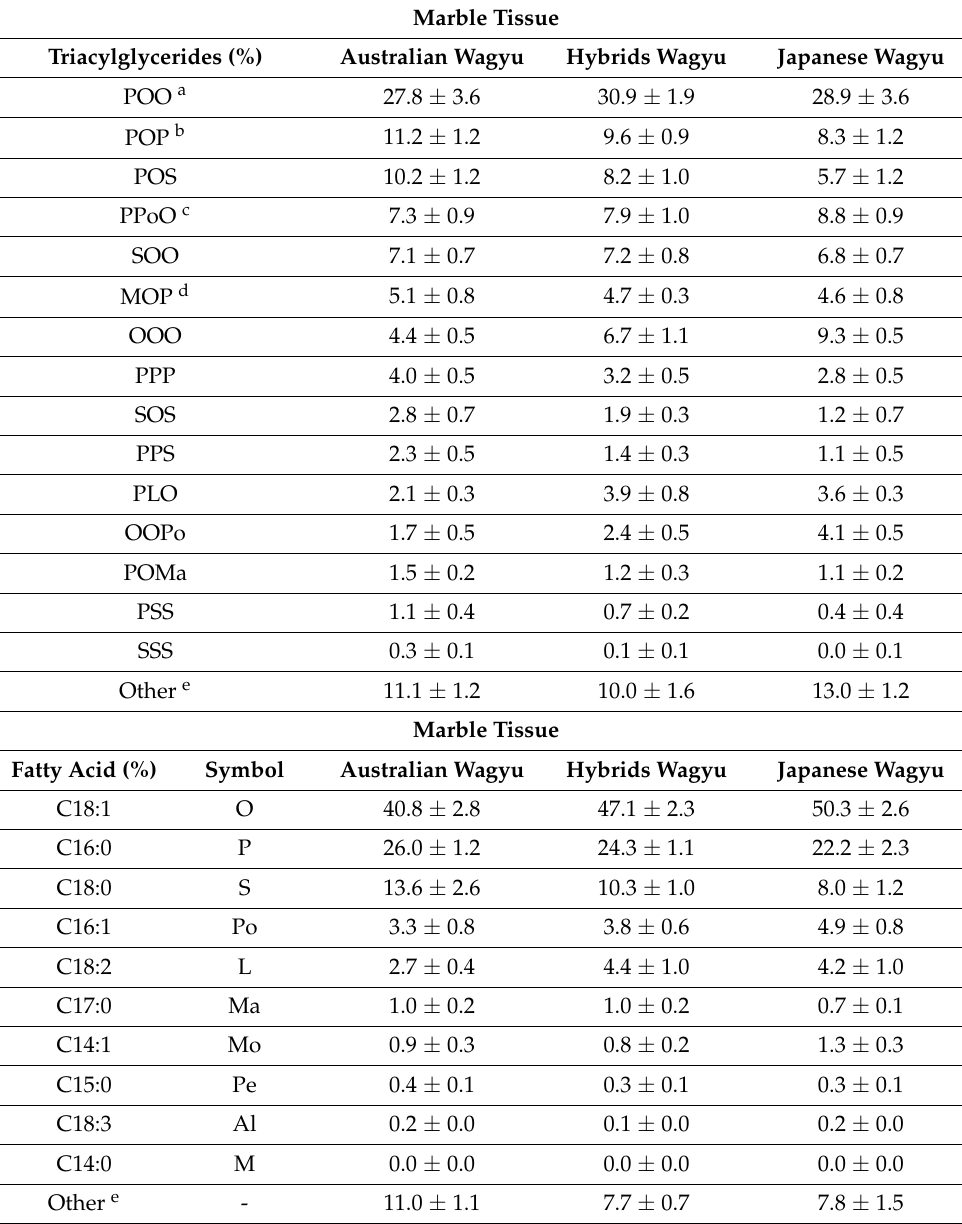
Table 2. TGs and fatty acids in the marble tissue of each Wagyu